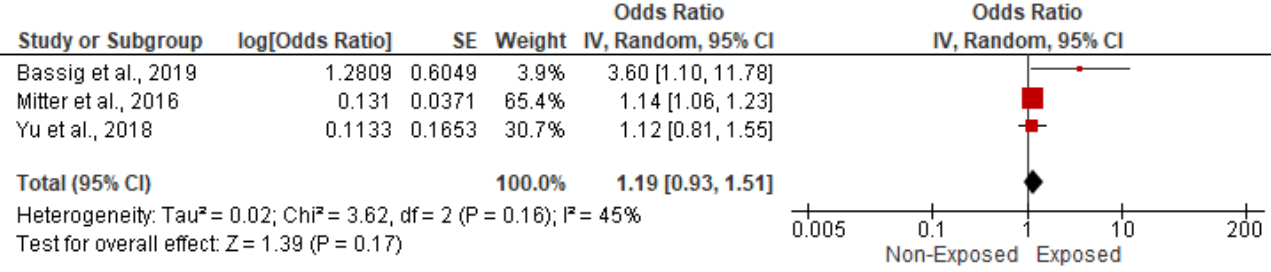
Figure 11. Forest plot of summary analysis of the Odds ratio and 95% CI of the association between HAP and ischemic heart disease. The size of the red squares is proportional to the statistical weight of each trial. The gray diamond represents the pooled point estimate. The positioning of both diamonds and squares (along with 95% CIs) beyond the vertical line (unit value) suggests a significant outcome (IV = inverse variance).